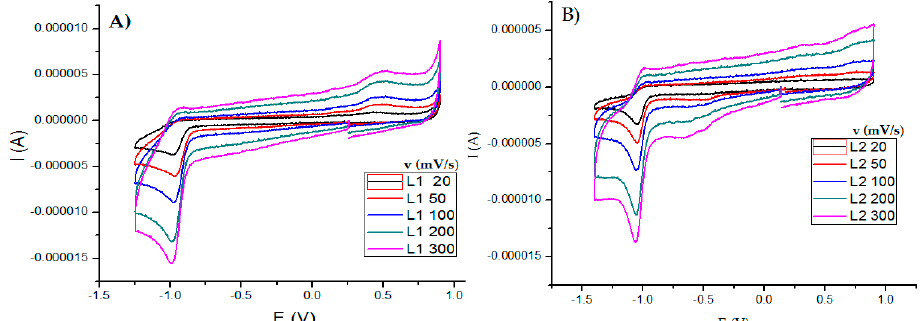
Figure 6. Cyclic voltammograms for 0.001 M ligands in DMSO with 0.1 M tetrabutylammonium hexafluorophosphate. ( A ) Curcumin and ( B ) dimethoxycurcumin. Scan rates in the range of 20–300 mV/s. All experiments were referenced to the pair Fc + /Fc.